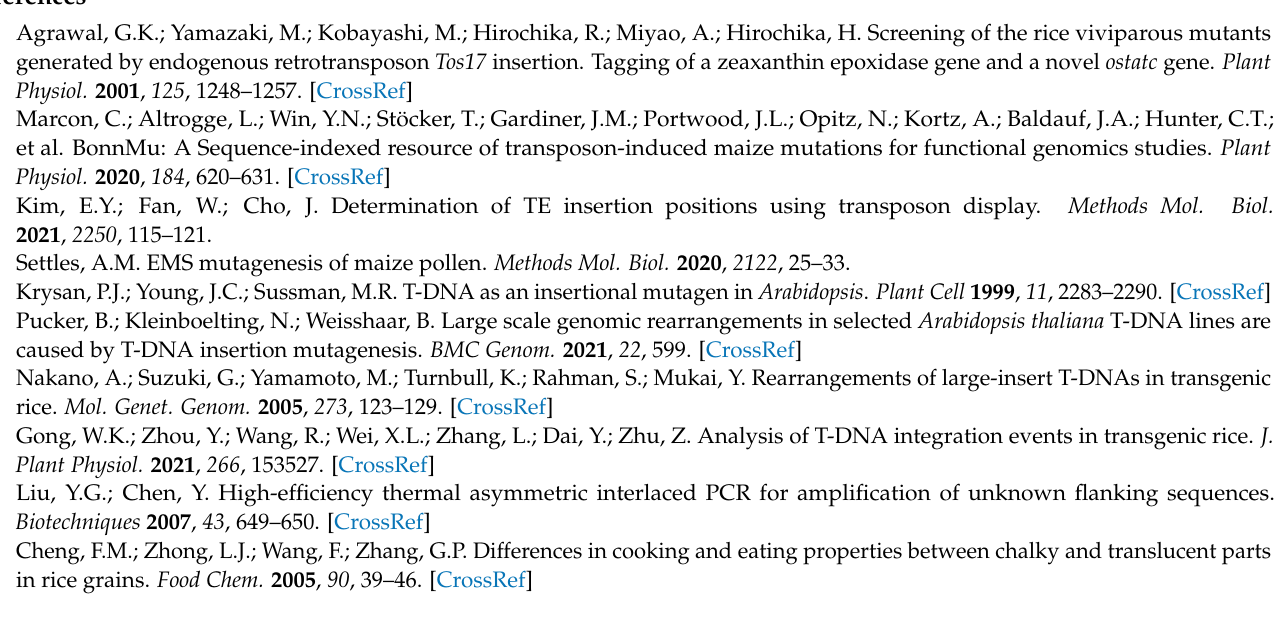
study. Table S2: Rice genes used in endogenous gene expression